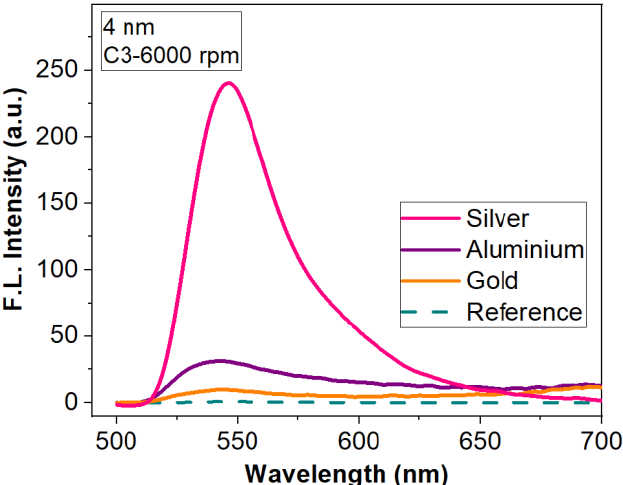
Figure 9. Fluorescence enhancement for tree types of metasurfaces (nanostructured 4 nm-thick Al, Ag and Au thin films) for R6G:PMMA- C 3 thin film deposited at 6000 rpm.